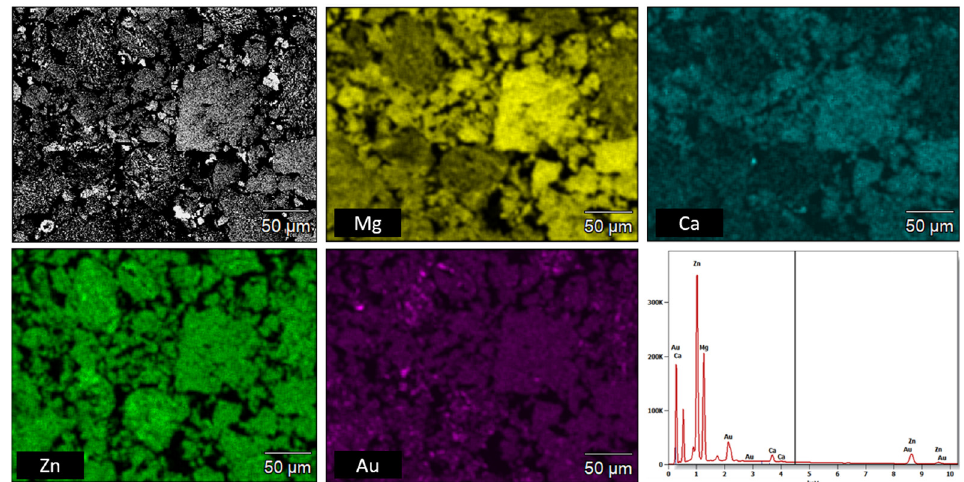
Figure 5 . The SEM image with the region marked as “III” in the Figure 4 obtained for the sintered Mg 63 Zn 30 Ca 4 Au 3 alloy. The image features the transcrystalline fracture.